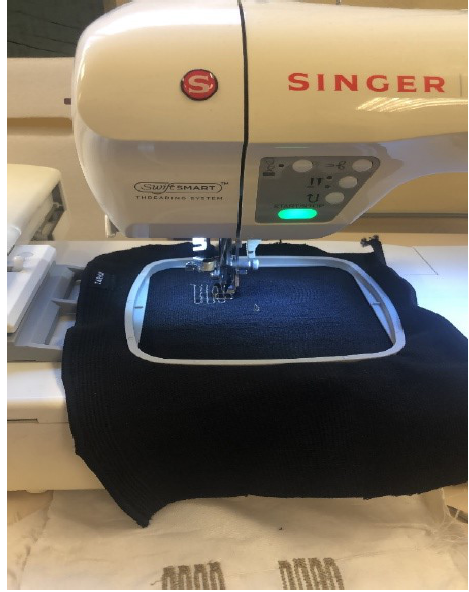
Figure 2. Embroidered sensor manufacturing.